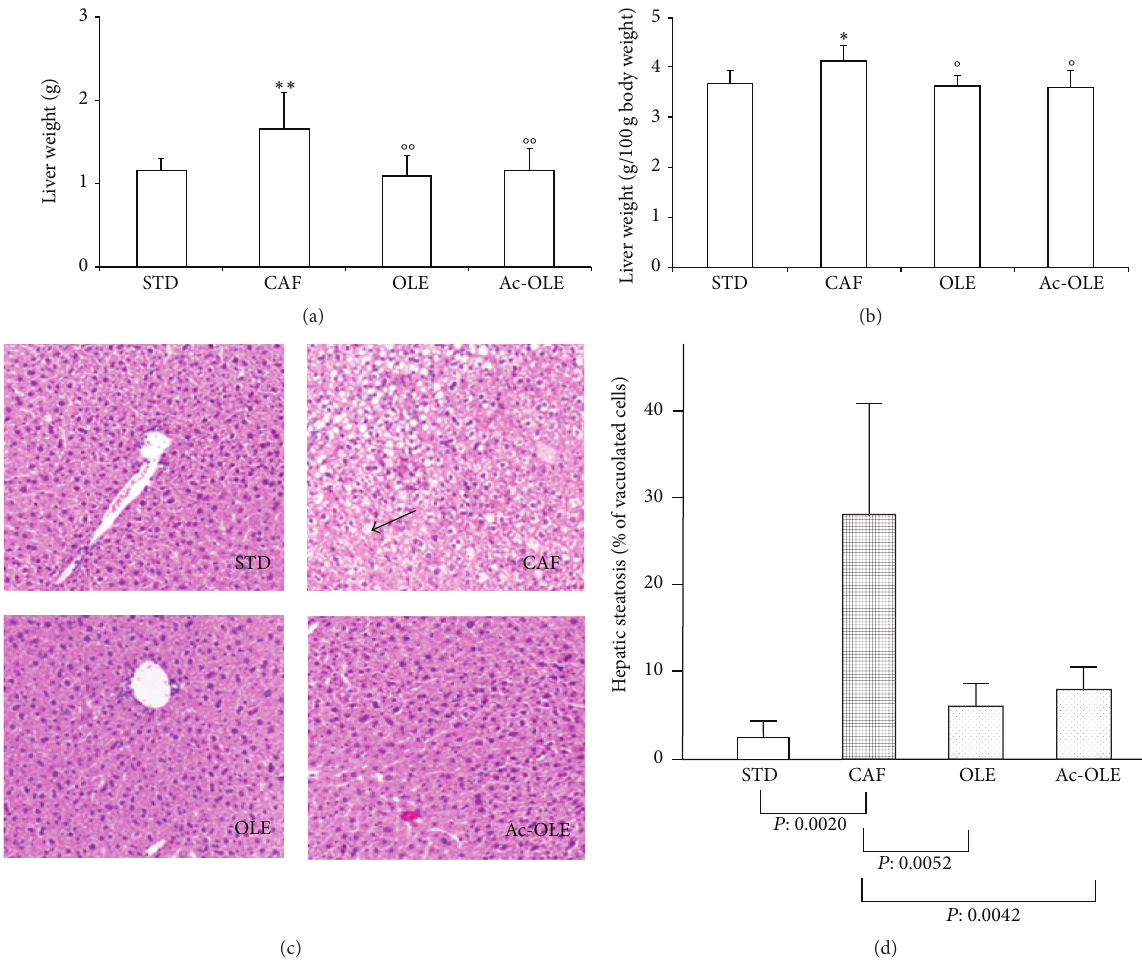
Figure 2: Effects of Ole and Ac-Ole on liver weight and liver histology. (a) Liver weight was significantly reduced in mice fed with a caf diet supplemented with Ole or Ac-Ole. (b) Relative liver weight. (c) Hematoxylin and eosin staining of liver sections (10x magnification). The liver of mice CAF was rich in fat vacuoles (indicated by the arrow). (d) Quantification of steatosis was expressed as mean of percentage of vacuolated cells calculated for each mouse liver. Values are mean ± SD. ∗ 𝑃 < 0.05 and ∗∗ 𝑃 < 0.01 compared to STD; ∘ 𝑃 < 0.05 and ∘∘ 𝑃 < 0.01 compared to